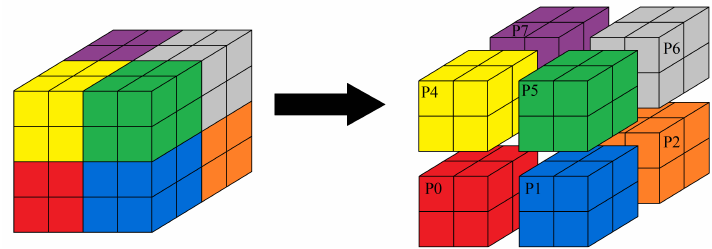
Figure 2. Spatial domain decomposition spreads into eight processors.